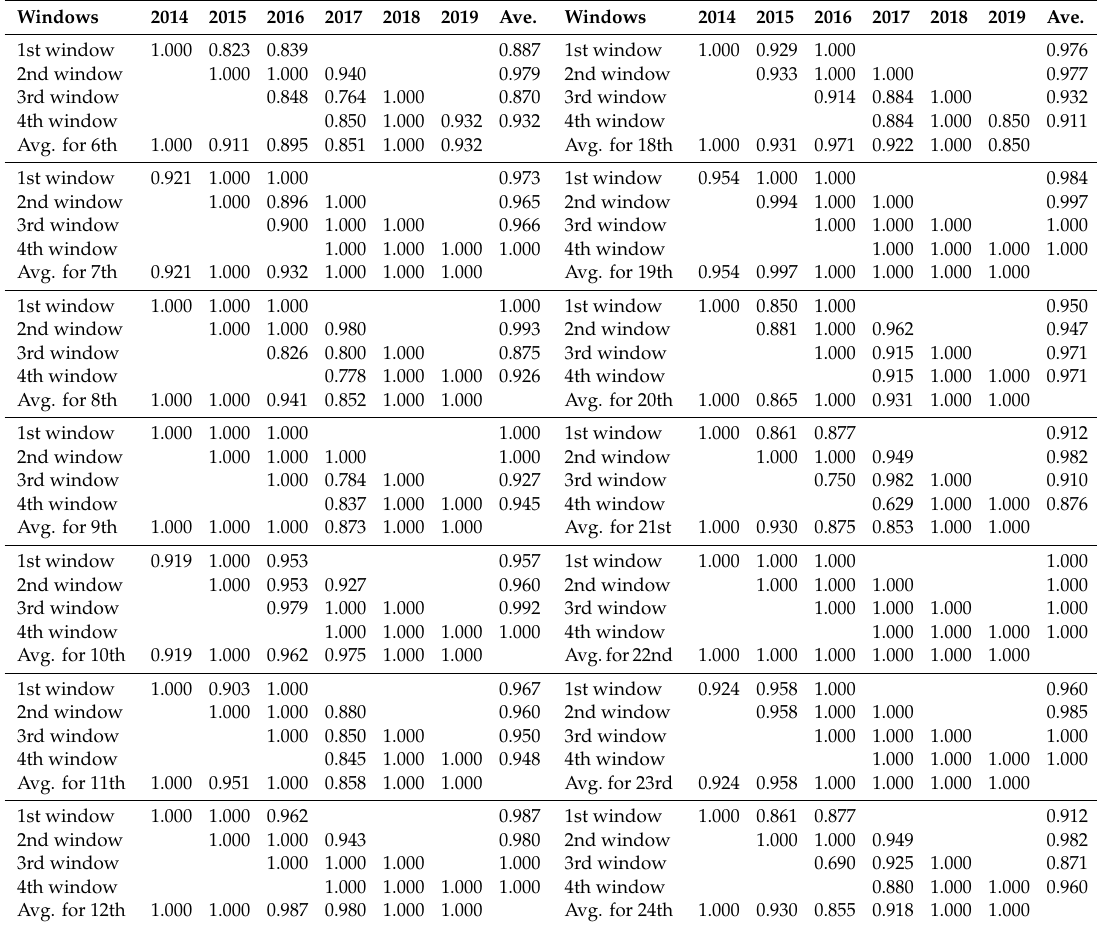
Based on the FDH model for Figure 6: